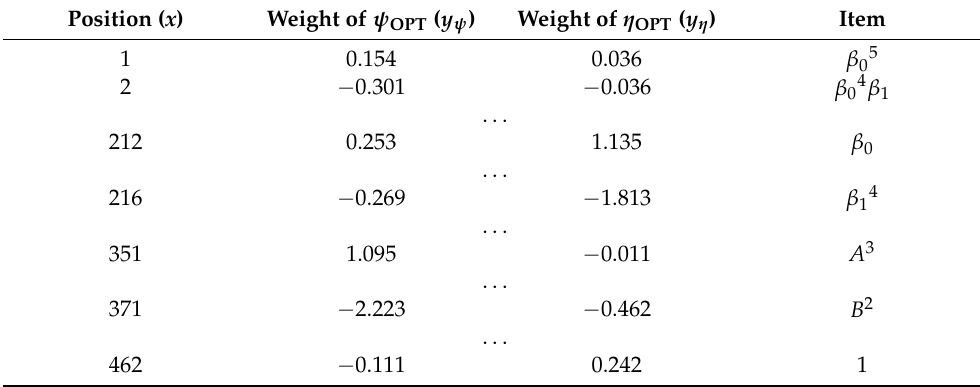
Figure 10 . The relation spectrum: ( a ) the relation spectrum of total pressure coefficient; ( b ) the relation spectrum of efficiency